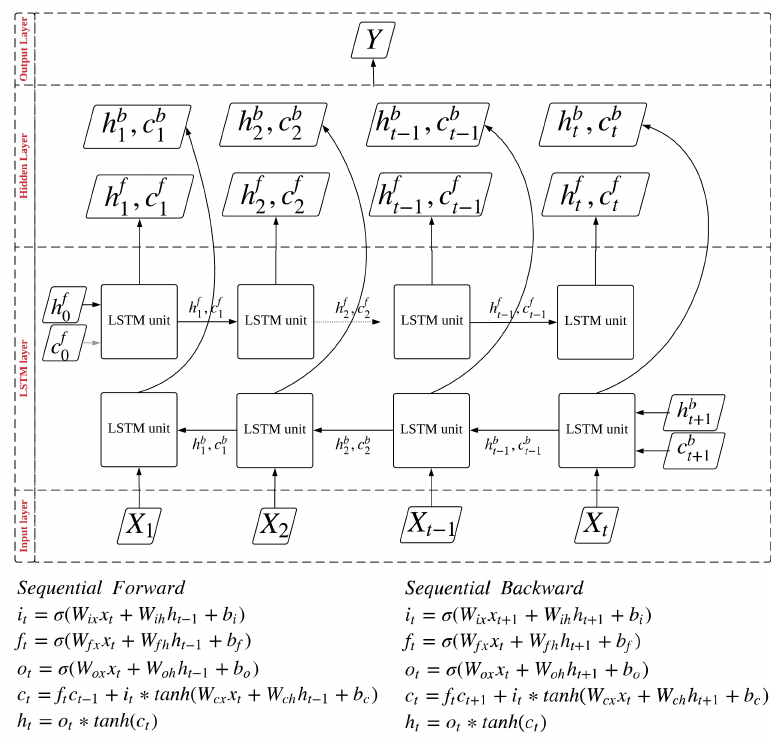
Figure 5. Structure of the bi-LSTM method, similar to the LSTM method (Figure 4), the training is carried out in both directions (i.e., both sequential forward and sequential